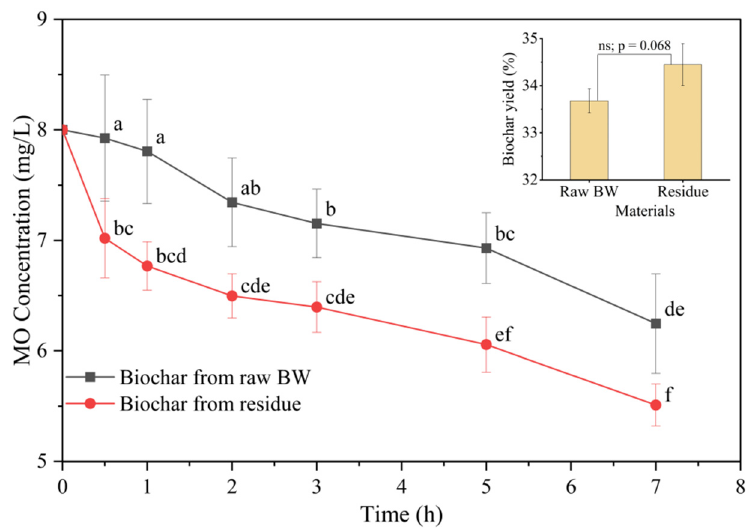
Figure 6. Biochar yield after pyrolysis in the second stage and decolorization of MO (methyl orange) during 7h reaction by raw BW and residue of HTE (160 ℃ , 30 min). The alphabets on the bar graph indicate statistical difference (P < 0.05).